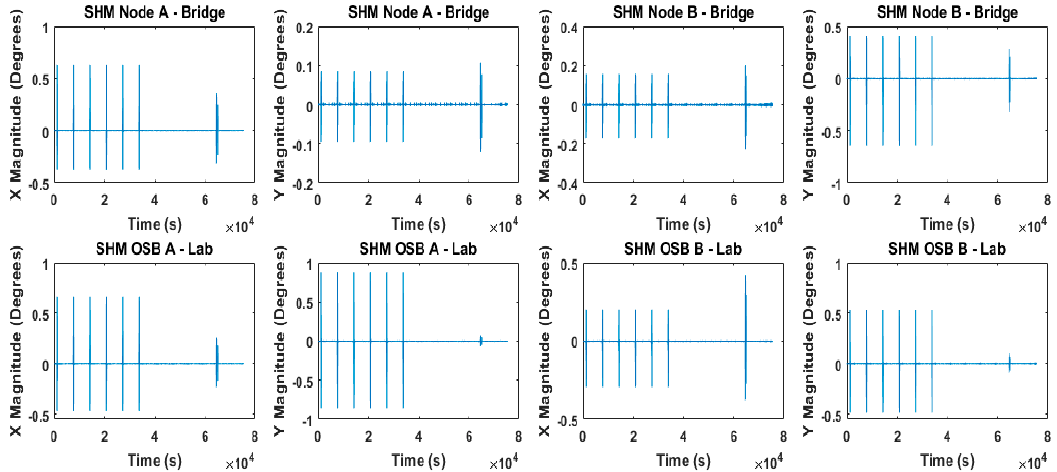
Figure 21. Filtered signals with Butterworth (band-pass) filter (order = 2) for two sites.